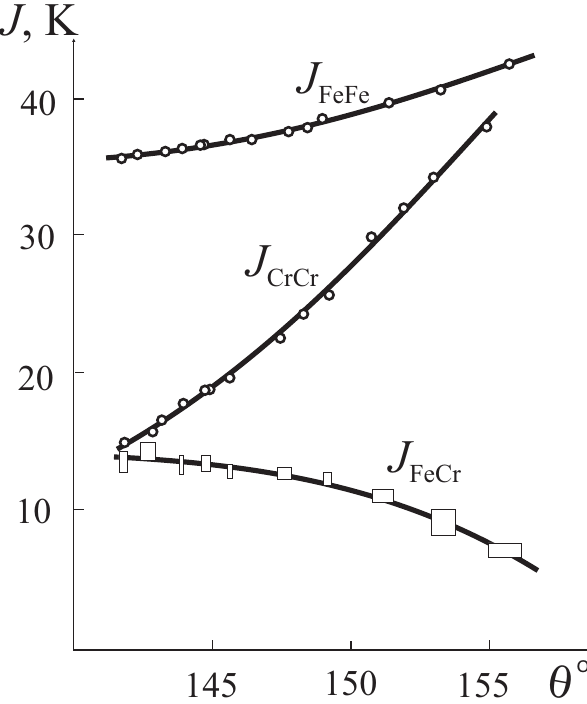
Figure 3. Dependence of the Fe 3 + -Fe 3 + , Cr 3 + -Cr 3 + , Fe 3 + -Cr 3 + exchange integrals (in K) on the superexchange bond angle in